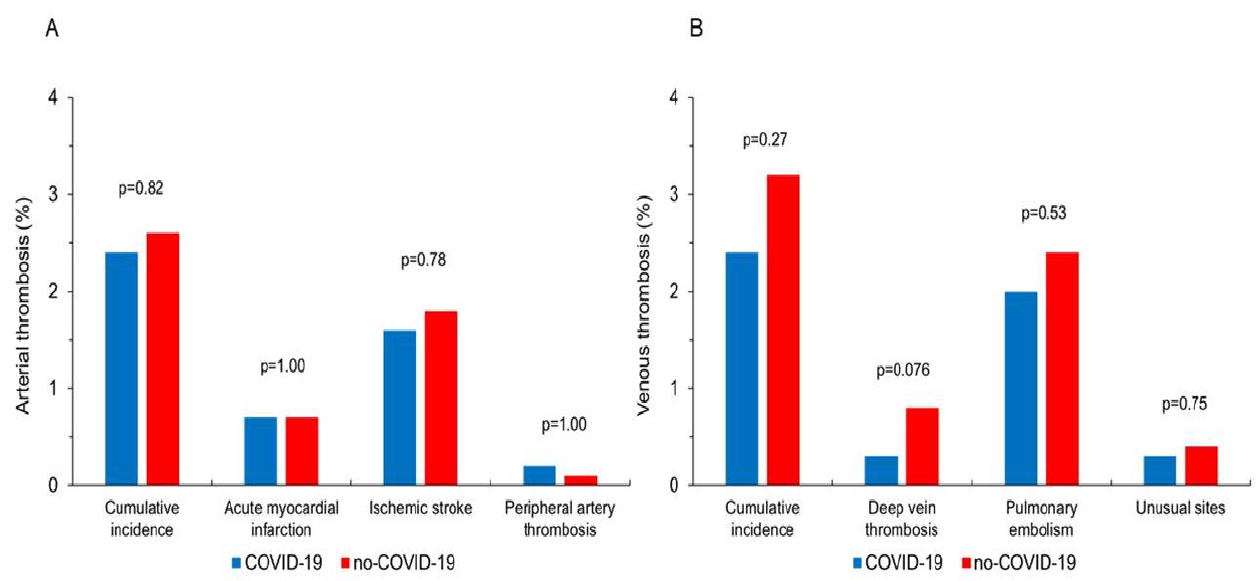
Figure 1. The graph shows the incidence of arterial ( A ) and venous ( B ) thrombotic events in the propensity score-matched subgroups of COVID-19 and no-COVID-19 patients.